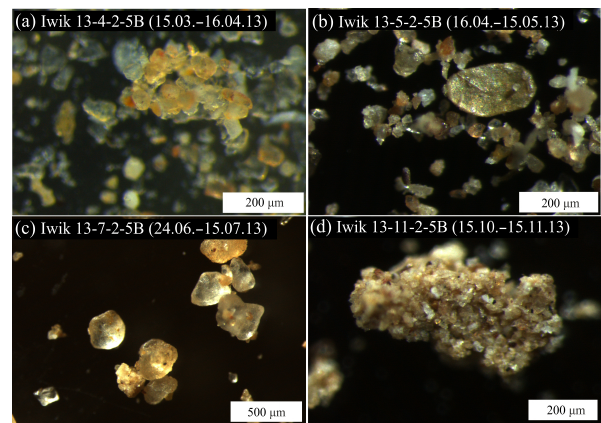
Figure 5. Microscopic photographs of selected dust samples from the Iwik 2013 time series. (a) Spring dust sample with a ∼ 250 × 150µm aggregate; (b) spring dust sample with a ∼ 200 × 100µm mica chip; (c) summer dust sample with ∼ 200 × 200µm quartz grains; (d) autumn dust sample with a ∼ 600 × 250µm ag-